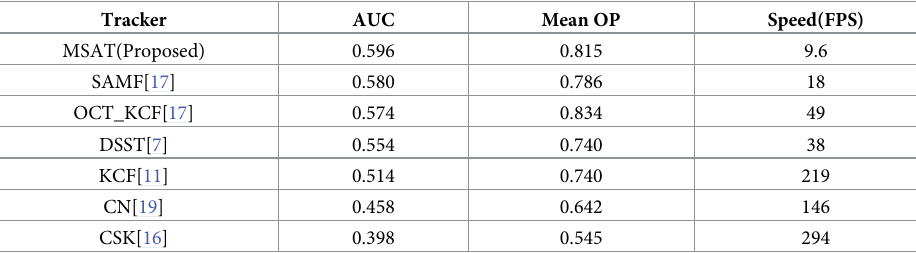
Table 1. Overall comprehensive evaluations of kernel correlation filter based